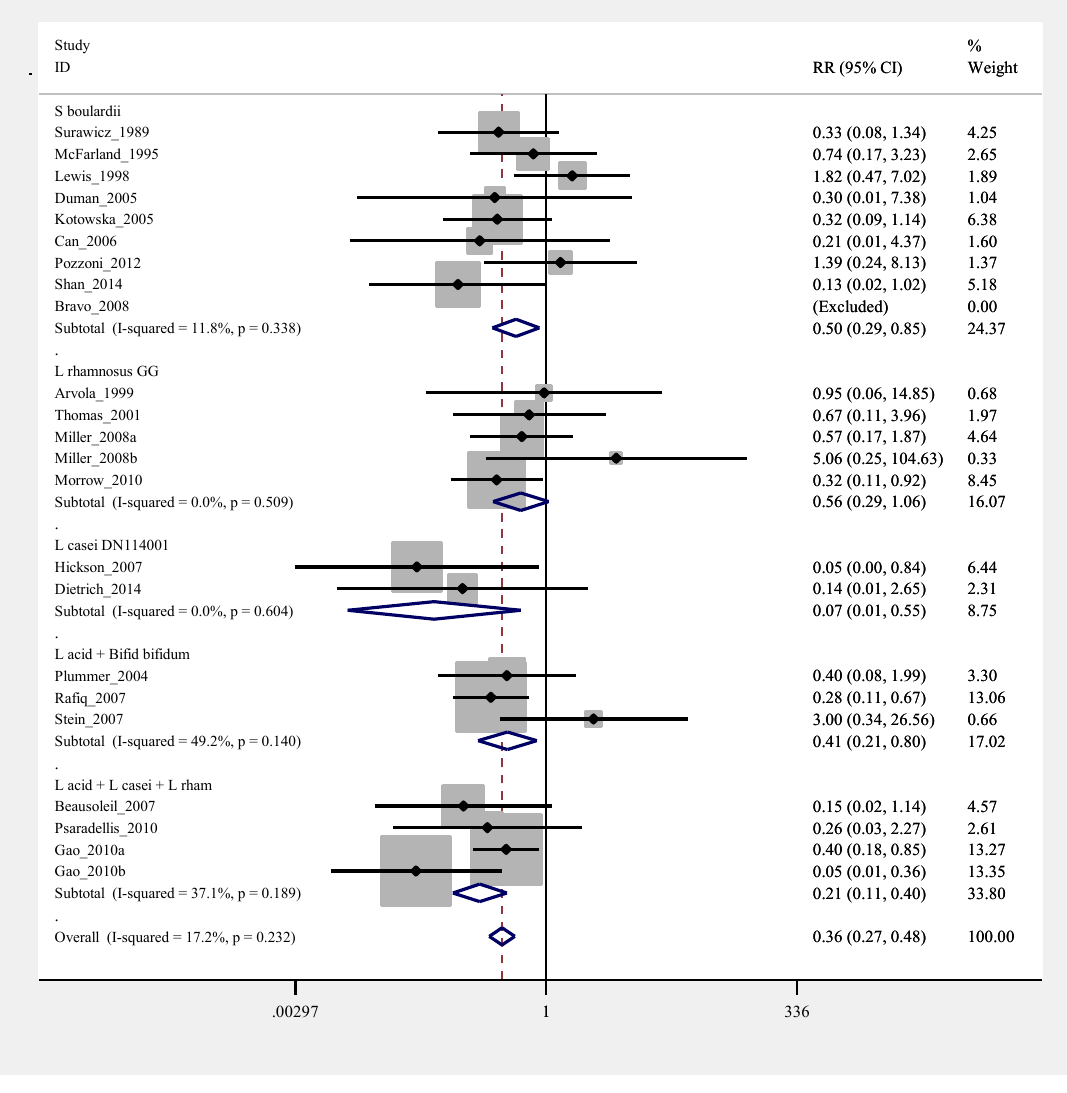
Figure 2. Forest plot of fixed effects model of meta-analysis of primary prevention of C. difficile disease by sub-group of probiotic type, x-axis indicates relative risk.